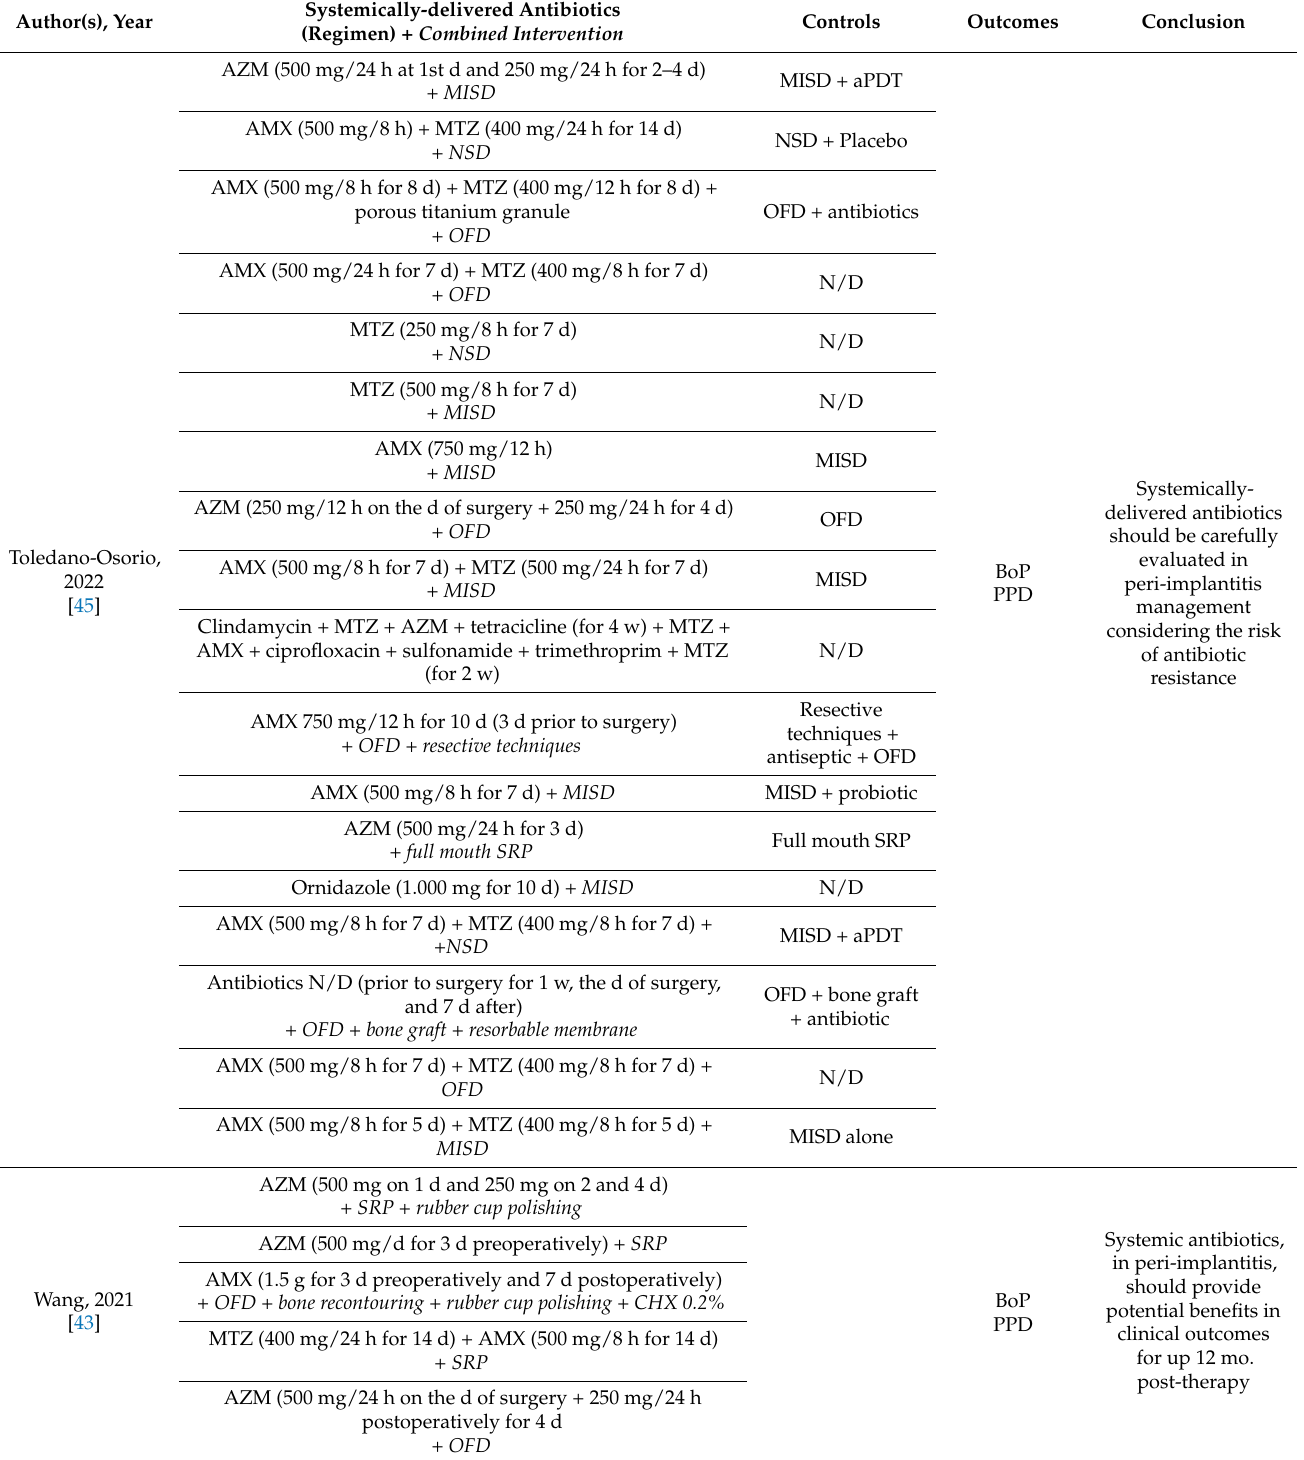
Table 6. Characteristics of systemically-delivered antibiotics combined with other interventions in the treatment of